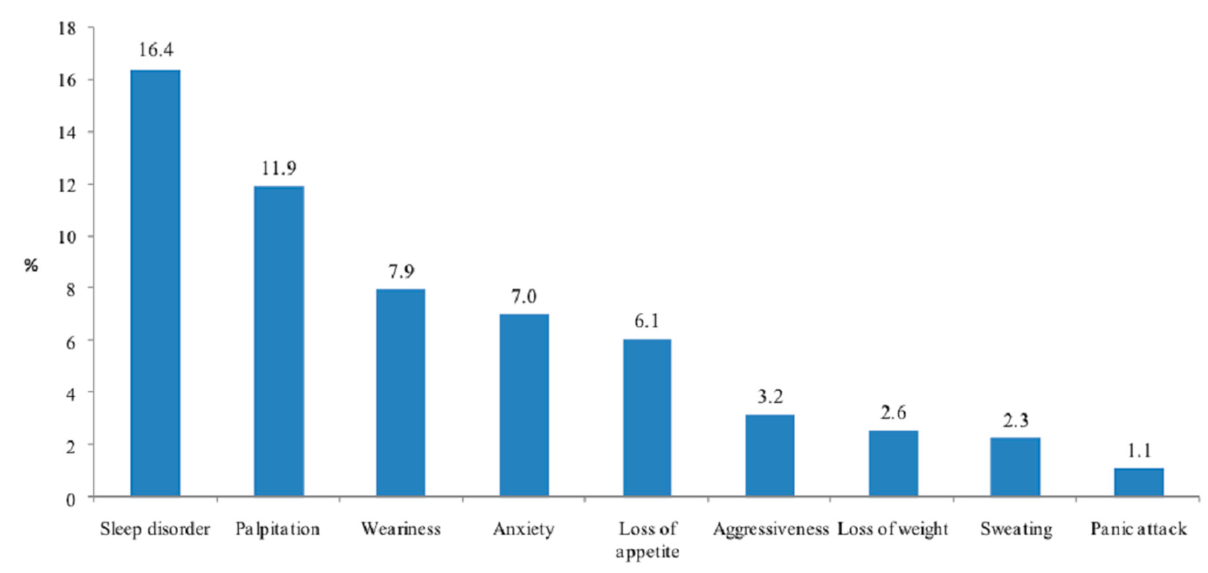
Figure 2. Adverse effects reported after neuroenhancer use by students at Cluj-Napoca, Rouen, and Opal Coast University.